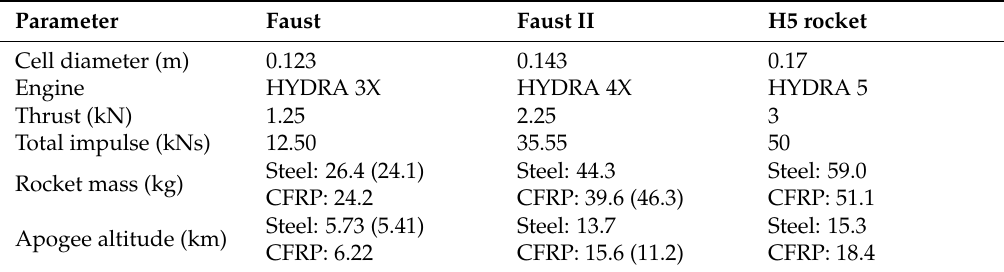
Table 7. Comparison of rocket design parameters for three different engines with two different casing materials. Results presented in parentheses correspond to real flight data for Faust and CAD data for Faust